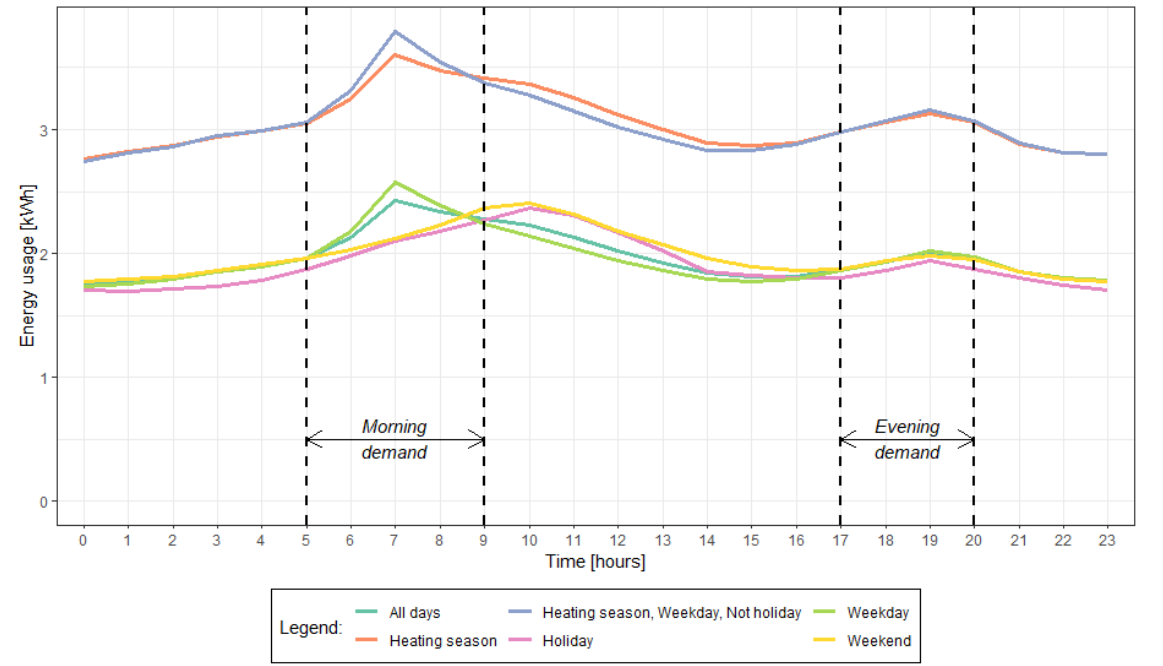
Figure 3. Daily heating load profiles for all week, weekdays, and weekends based on average hourly consumption. N = 6,475,392, n = 803.